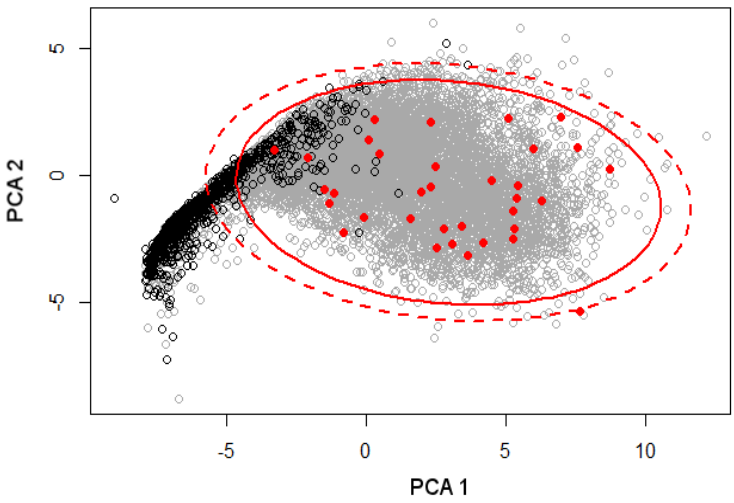
Figure 8. Field plot distribution (in red) on a space plane of principal component 1 (PC1) versus principal component 2 (PC2). The grey circles represent the mangrove forest area and the black circles represent the non-mangrove area. The internal ellipse (solid line) corresponds to 95% confidence and the dashed ellipse to 98% confidence.